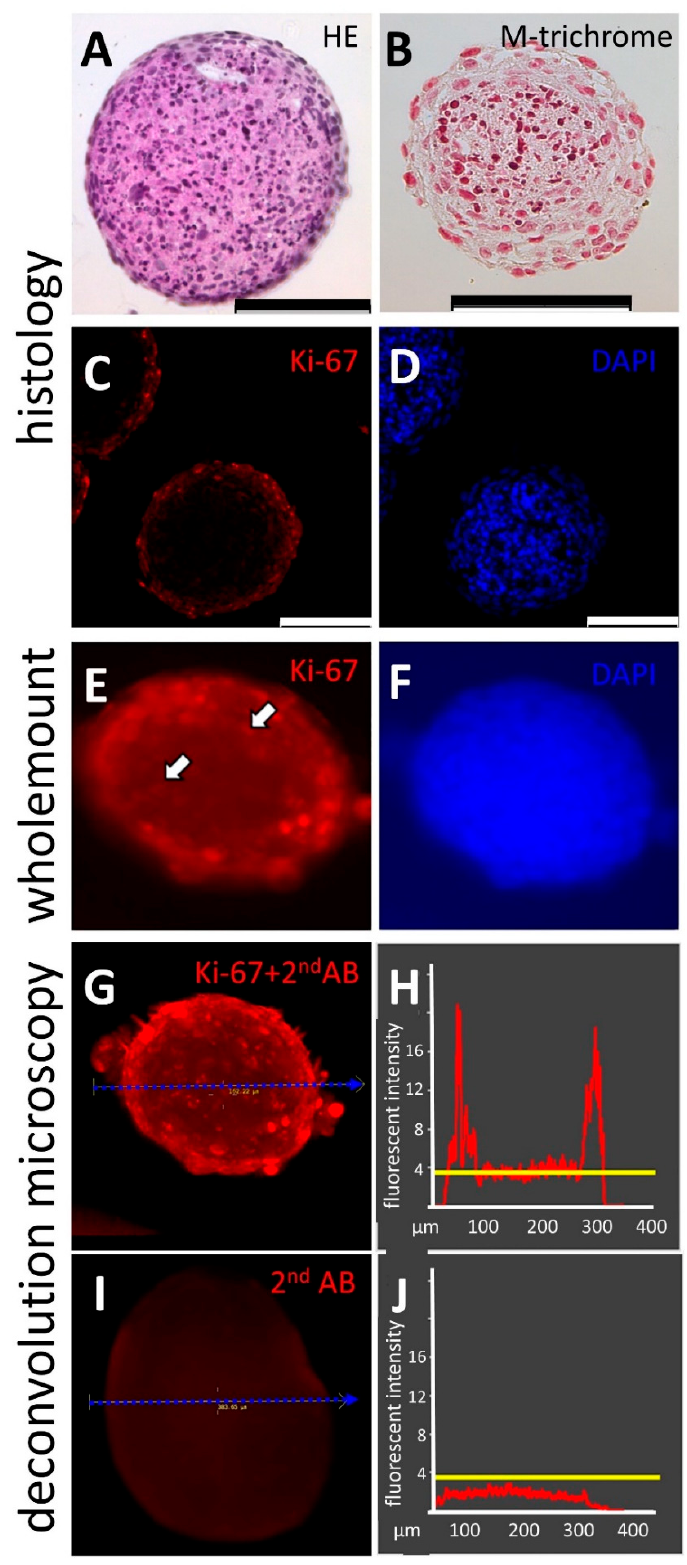
Figure 5. ( A – D ): the histological analysis of cell aggregates made from a human osteoblasts cell line, hFOB1.19 on 3 µ m paraffin sections (Supplementary Material S5), ( A ): hematoxylin-eosin staining; ( B ): Masson’s Trichrome staining; ( C ): the immunohistological analysis of the proliferation marker Ki-67 ( D ): staining of cell nuclei with the DNA-binding fluorophore DAPI; ( E , F ): fluorescent